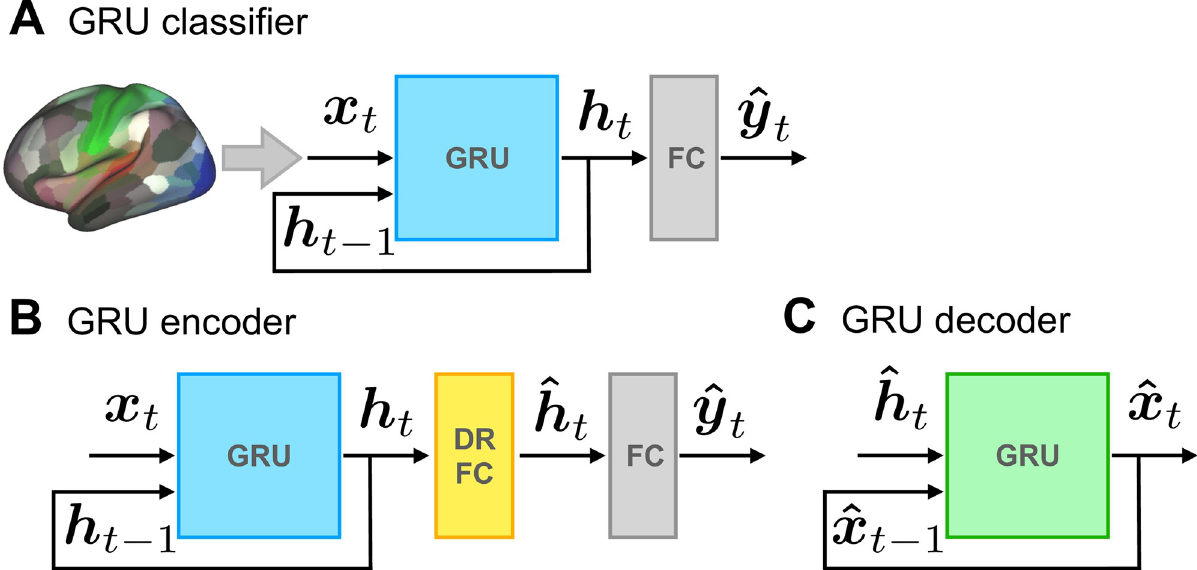
Fig 1. Model architectures based on neural networks with gated recurrent units (GRUs). (A) Classifier . At each time step, time series data, x t , provided inputs. The recurrent neural network transformed the inputs into a latent representation, h t , which then determined the output class scores, ^ y . The unit with highest activation determined the model’s prediction of the input stimulus at each time. (B) Dimensionality reduction . The encoder t shares the GRU component shown in A. GRU outputs, h t , were first linearly projected to a lower-dimensional space using a fully-connected layer (DR-FC). Classification was then performed based on the low-dimensional representation, ^ h trained independently to reconstruct the original brain signals based on the low-dimensional signals, ^ h